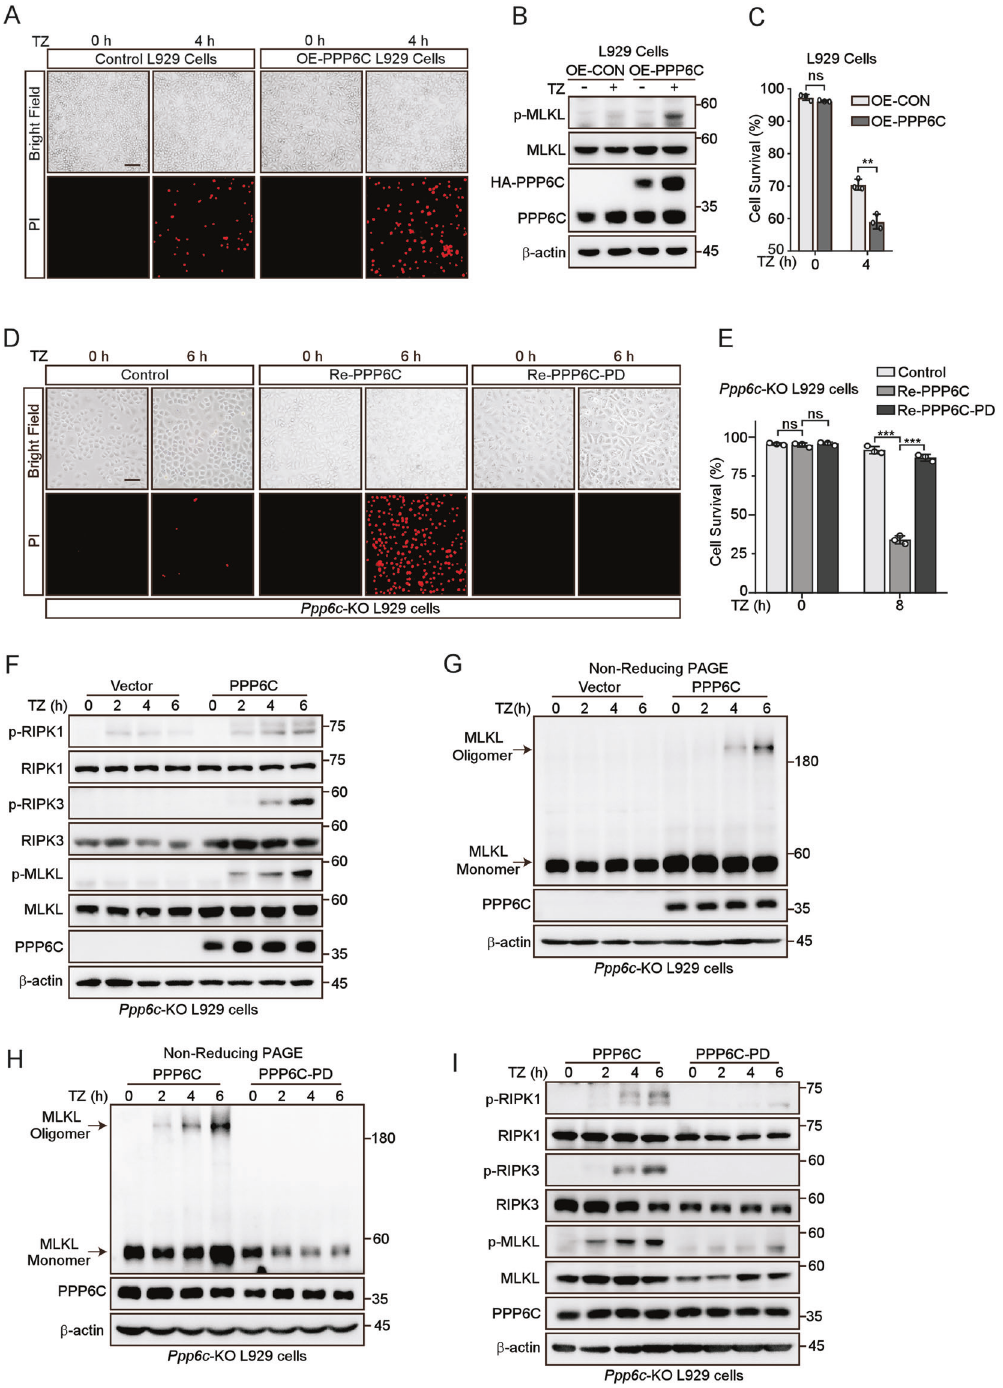
Fig. 2 Phosphatase activity of PPP6C is required for its role in regulating necroptosis. A , C Control and PPP6C-overexpression L929 cells were treated with TZ for 4 h, then stained with PI and analyzed under a microscope ( A ), or quanti fi ed by fl ow cytometer ( C ). Scale bar, 50 μ m. B Control and PPP6C-overexpression L929 cells were treated with TZ for 4 h and cell lysates were probed with indicated antibodies. D , E Ppp6c -KO cells were transduced with PPP6C or its phosphatase dead (PD) lentivirus and followed by the treatment with TZ for the indicated time. Cells were then stained with PI and analyzed under a microscope ( D ) or quanti fi ed by fl ow cytometer ( E ). Scale bar, 50 μ m. F , G Ppp6c -KO L929 cells were transduced with PPP6C lentivirus and followed by the treatment with TZ for the indicated time. Cell lysates were resolved on SDS-PAGE ( F ) or non-reducing PAGE ( G ) for immunoblot with indicated antibodies. H , I Ppp6c -KO L929 cells were transduced with PPP6C or PPP6C-PD lentivirus and followed by the treatment with TZ for the indicated time. Cell lysates were resolved on non-reducing PAGE ( H ) or SDS-PAGE ( I ) for immunoblot with indicated antibodies. Data shown are representative of three independent experiments and presented as means ± SDs of triplicates ( C , E ). ** p < 0.01, *** p < 0.001, with an unpaired Student ’ s t -test ( C ) or one-way ANOVA analysis ( E ).